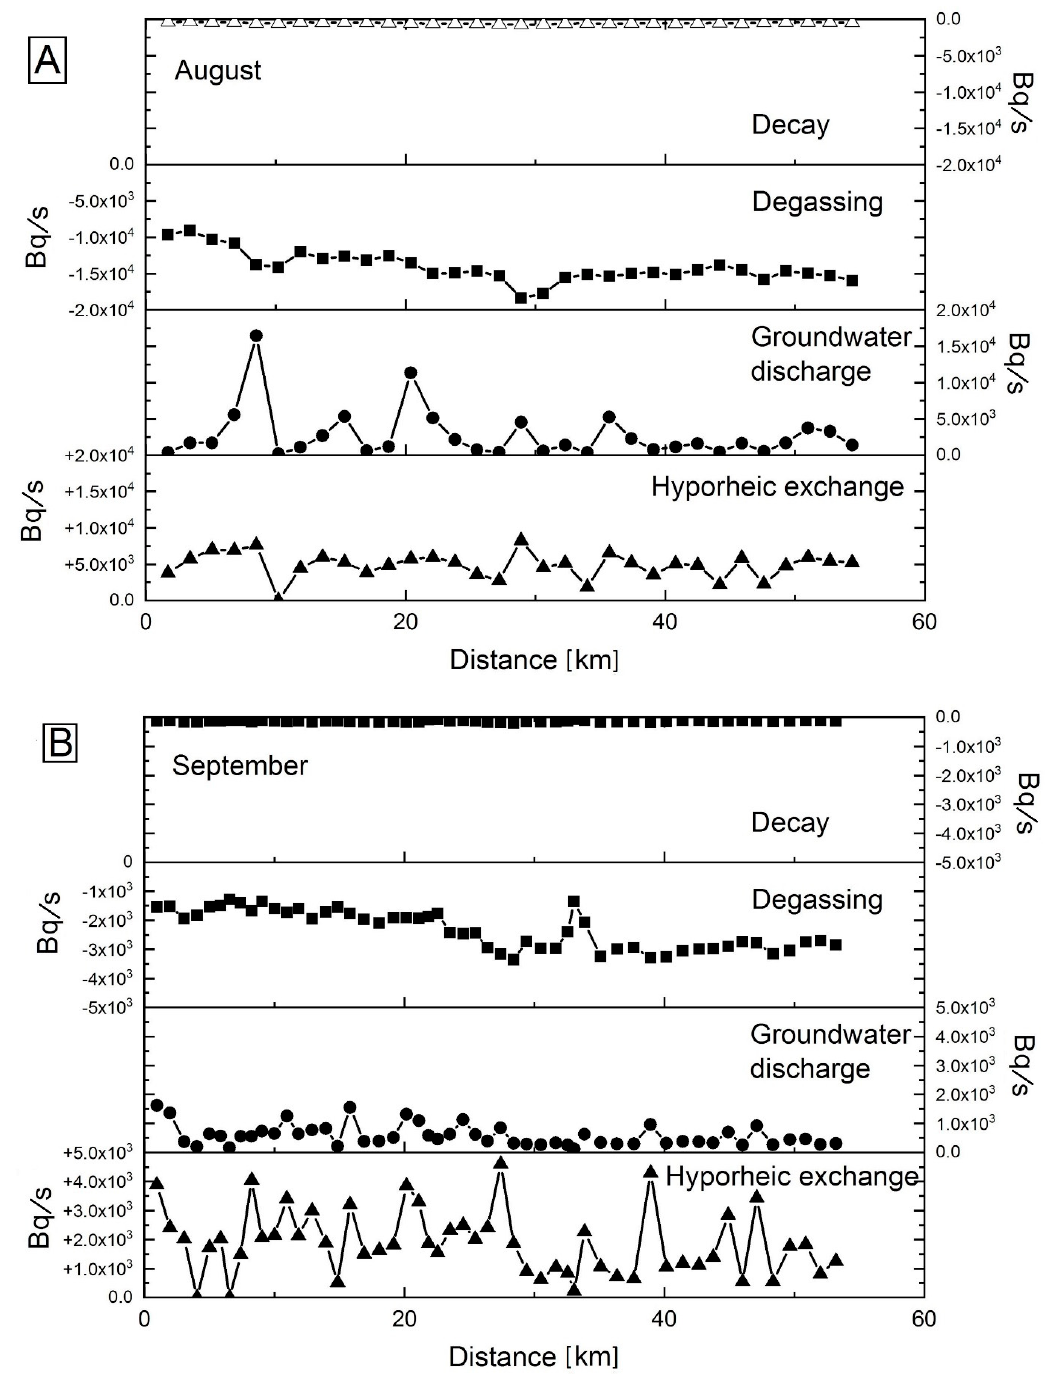
Figure 11. Loss and gain of radon in the radon mass-balance for ( A ) the first (August) and ( B ) the second (September) campaigns. Note different scales between the campaigns. Negative values indicate radon loss from the river and positive values gain in radon.